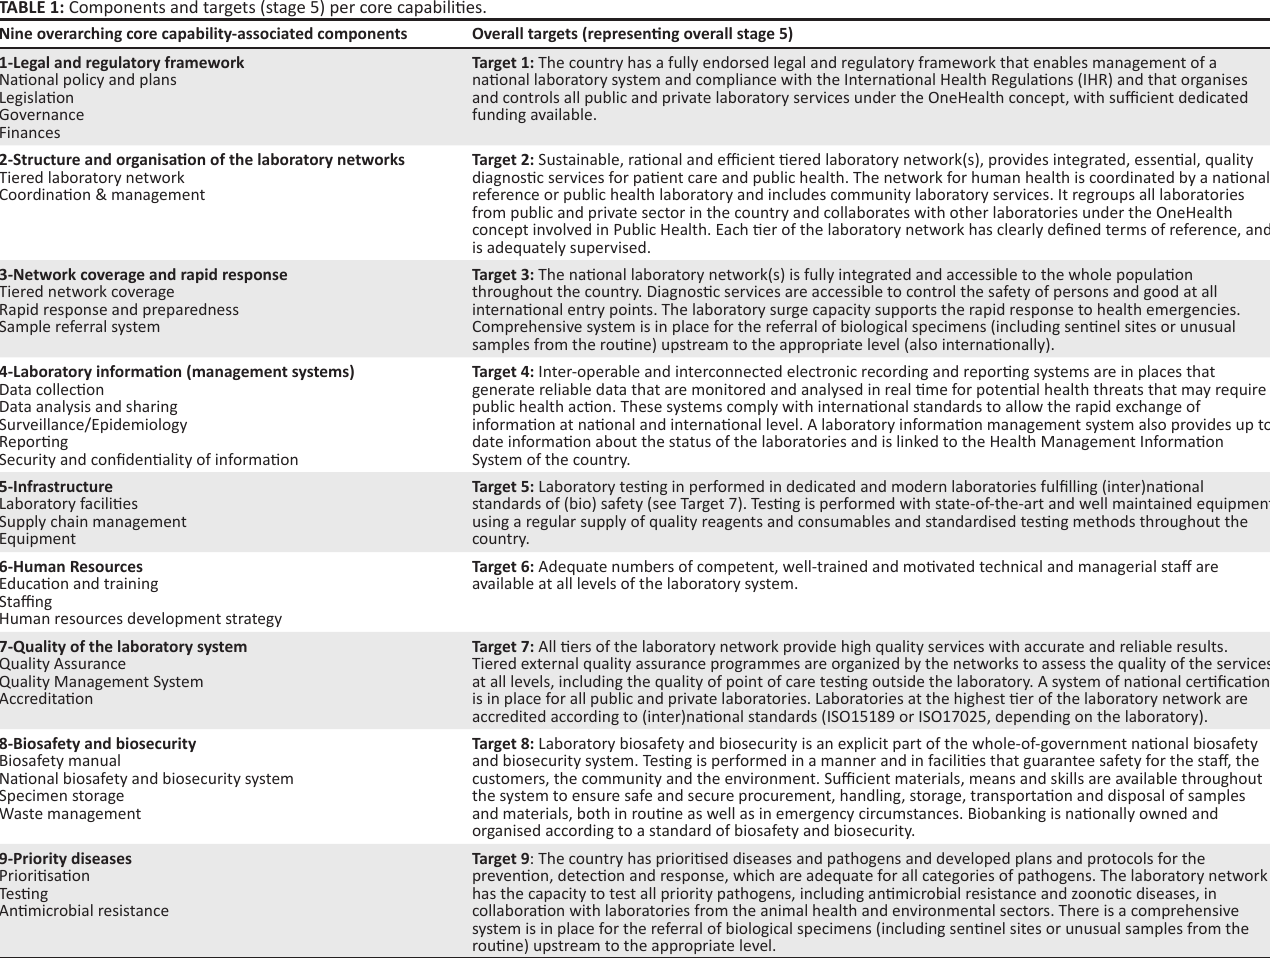
TABLE 1: Components and targets (stage 5) per core